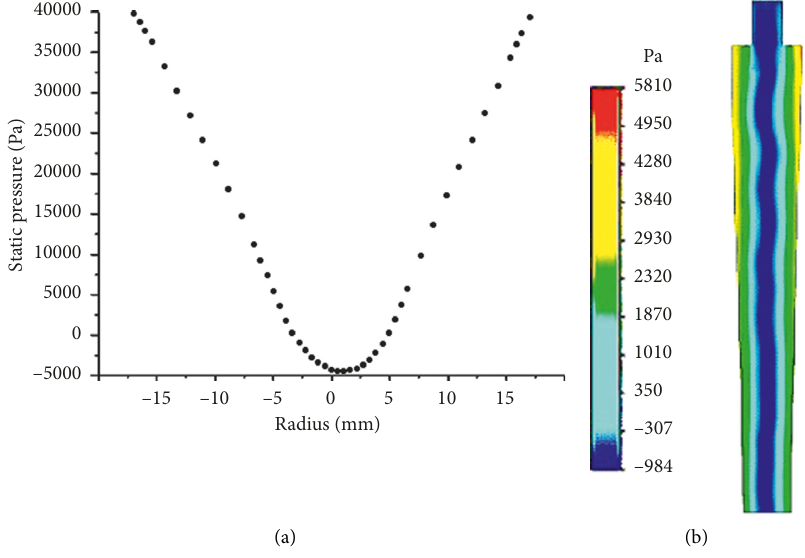
Figure 7: (a) Static pressure diagram and (b) contour, within the